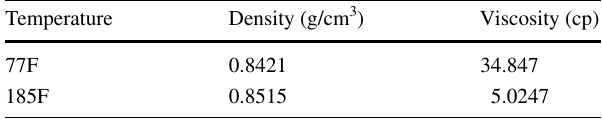
Table 1 Crude oil properties at two different